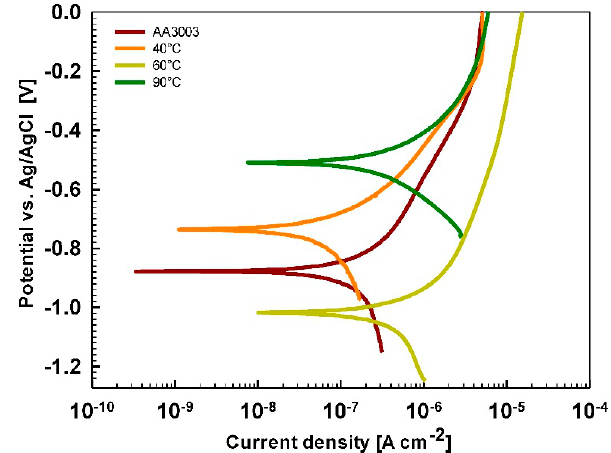
Figure A2. Potentiodynamic polarization curves recorded in simulated acid rain for AA3003 samples cleaned using different concentration of: ( a ) Surtec 132; ( b ) Surtec 089 at constant temperature 40 °C and time immersion 3 min.